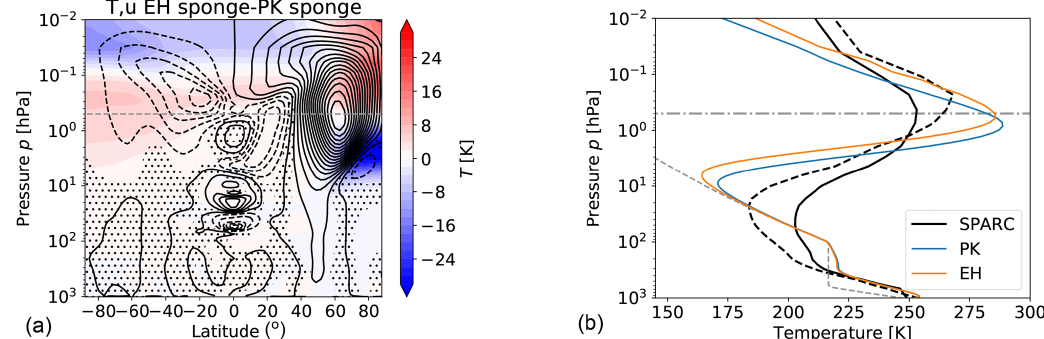
Figure 7. (a) Differences in zonal-mean temperature (contour interval is 2K) and zonal-mean zonal wind (contour interval is 2ms − 1 ) between a model simulation with exponentially increasing damping coefficient (EH) and a model simulation with quadratically increasing damping coefficient (PK) for p Tw = 100hPa and γ = 4Kkm − 1 without topography. Averages are performed over 1500d of simulation. Stippling indicates non-significant wind differences (on a 95% level, based on a t test performed on 30d means). (b) Polar winter temperature profiles of same model simulations averaged from 70 ◦ N to 90 ◦ N, with temperature profiles from the SPARC climatology in northern hemispheric winter conditions (solid black line) and southern hemispheric winter conditions (dashed black line) as well as the equilibrium temperature profile (dashed gray line). The dashed–dotted line marks the lower boundary of the sponge